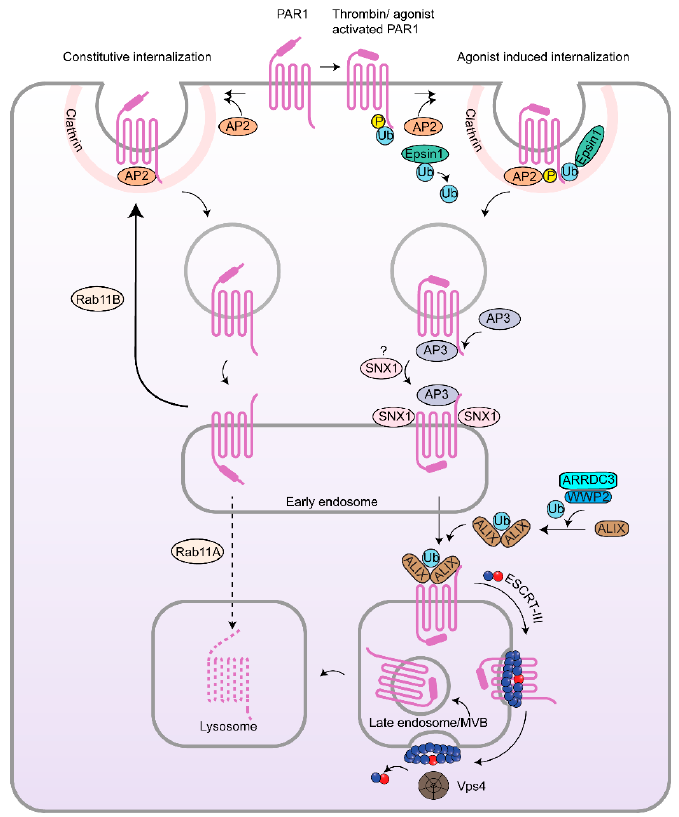
Figure 4. Endocytic trafficking of PAR1. PAR1 undergoes constitutive and agonist-activated internalization induced by thrombin cleavage of the N-terminus or by the peptide agonist SFLLRN. Unactivated PAR1 is constitutively internalized by AP-2 recognition of a distal tyrosine-based motif within the cytoplasmic C-terminus of PAR1. Internalized PAR1 is then sorted to early endosomes and then recycled back to the cell surface via a Rab11B-dependent pathway, whereas a small pool of receptor escapes recycling and is sorted by Rab11A to lysosomes and degraded. In contrast, agonist activation of PAR1 results in rapid phosphorylation and ubiquitination and internalization through a dynamin- and clathrin-dependent pathway mediated by AP-2 and epsin-1. AP-2 binds the phosphorylated distal C-terminus of activated PAR1 rather than the tyrosine-based motif to regulate activated PAR1 internalization. PAR1 activation also promotes epsin-1 deubiquitination, facilitating the ability of epsin-1 to bind activated PAR1 to facilitate internalization. Internalized PAR1 is then sorted sequentially at early endosomes by engaging AP-3 and SNX1 followed by ALIX, which requires ARRDC3 and WWP2-mediated ALIX ubiquitination and dimerization. ALIX, ARRDC3 and WWP2 are essential for targeting PAR1 to intraluminal vesicles of multivesicular bodies (MVBs)/late endosomes via ECSRT-III charged MVB protein 4 (CHMP4) and AAA-ATPase vacuolar protein sorting 4 (Vps4). Degradation of PAR1 in lysosomes is ultimately required for signal termination.